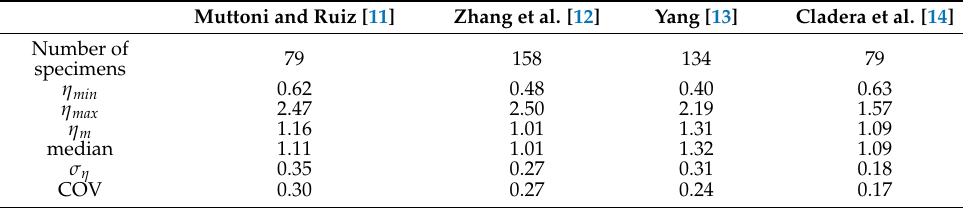
Table 1. Statistic assessment of models for all members (Table